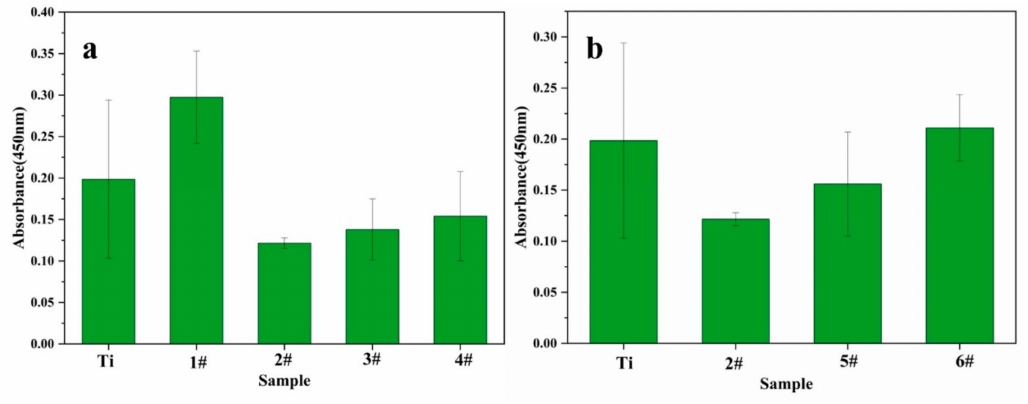
Figure 6. The platelet activation. ( a ) Different bias voltage, ( b ) different copper content.